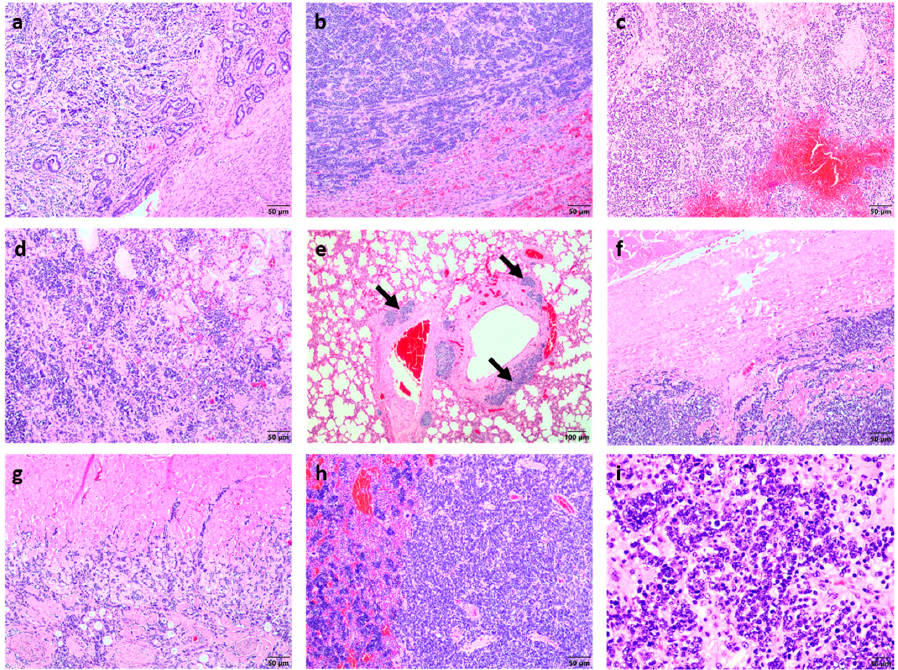
Figure 2. Histopathological appearance of the tumour cells in the different tissues. ( a ) The neoplastic cells in the uterus formed dense cellular nodules of various sizes consisting of nests, tubules, and acini of neoplastic cells within an abundant fibrovascular stroma (H&E stain, bar = 50 µ m). ( b ) The hepatic parenchyma contained multiple neoplastic infiltrates forming nests, tubules, and acini within a fibrovascular stroma, compressing the hepatocytes to the side (H&E stain, bar = 50 µ m). ( c ) The splenic red pulp was completely obliterated by neoplastic cell infiltration (H&E stain, bar = 50 µ m). ( d ) The pulmonary parenchyma showed multifocal clusters of neoplastic cells similar to those seen in the liver and uterus, resulting in areas of consolidation (H&E stain, bar = 50 µ m) with ( e ) multiple neoplastic cells in the peribronchiolar lymphatic vessels (arrows) (H&E stain, bar = 100 µ m). ( f ) The nodule from the thoracic parietal pleura showed proliferation of multiple neoplastic cells (H&E stain, bar = 50 µ m). ( g ) The epicardium and myocardium were similarly infiltrated by the neoplastic cells (H&E stain, bar = 50 µ m). ( h ) The bone marrow had a lack of adipocytes with multiple neoplastic cells present (right-hand side; H&E stain, bar = 50 µ m). ( i ) Higher magnification of the neoplastic cells revealed medium-sized neoplastic cells with scant cytoplasm, hyperchromatic nuclei, and a very high mitotic rate (H&E stain, bar = 10 µ